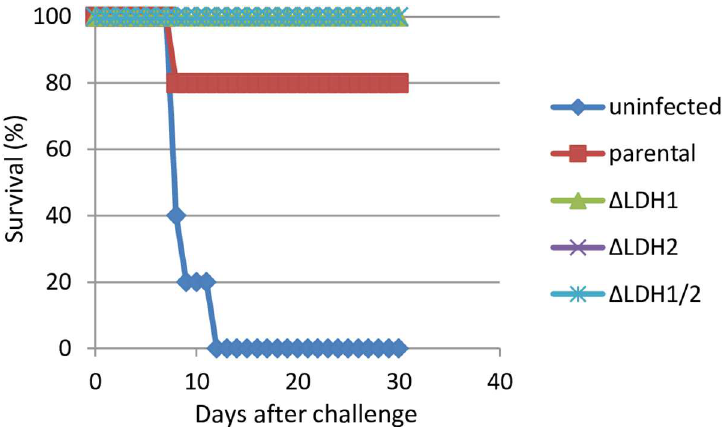
Fig 5. Protective immunity after primary infection. 10 3 tachyzoitesof LDH knockout and parental strains were infected into Balb/c mice. Mice were challenged with 100 parasites of virulent RH strain 30 days after primary infection and were monitoredfor another30 days for survival. Group of na ï vemice were also challenged (uninfected).